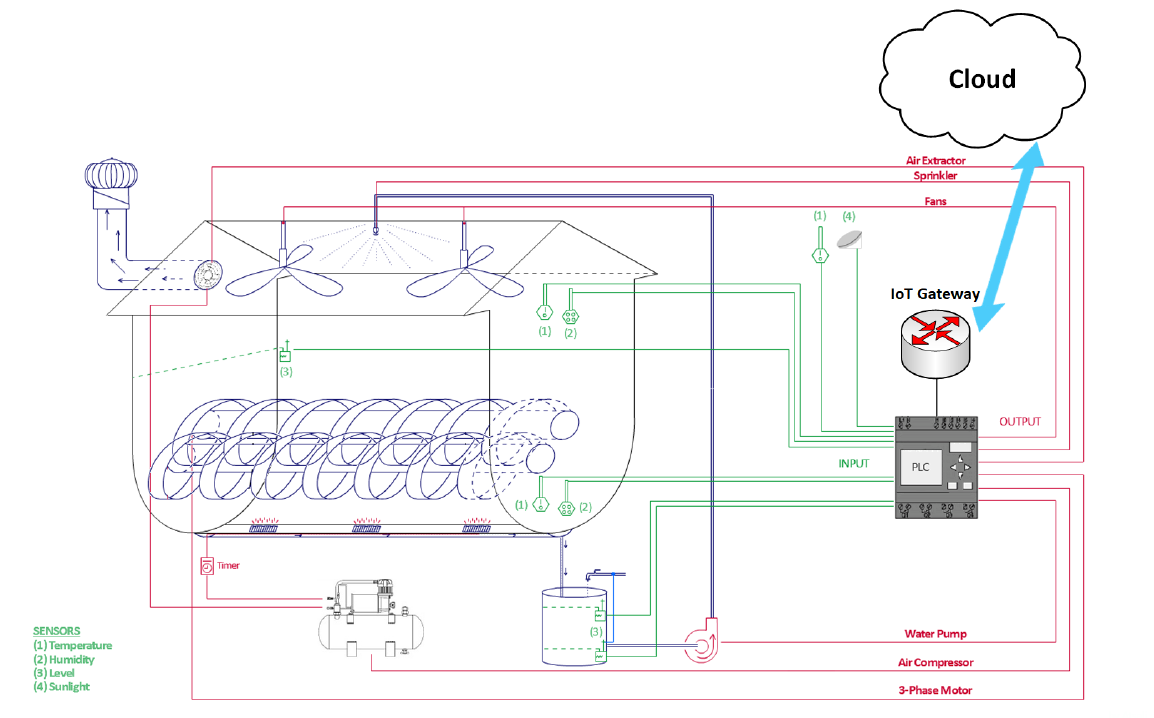
Figure 2. Composting